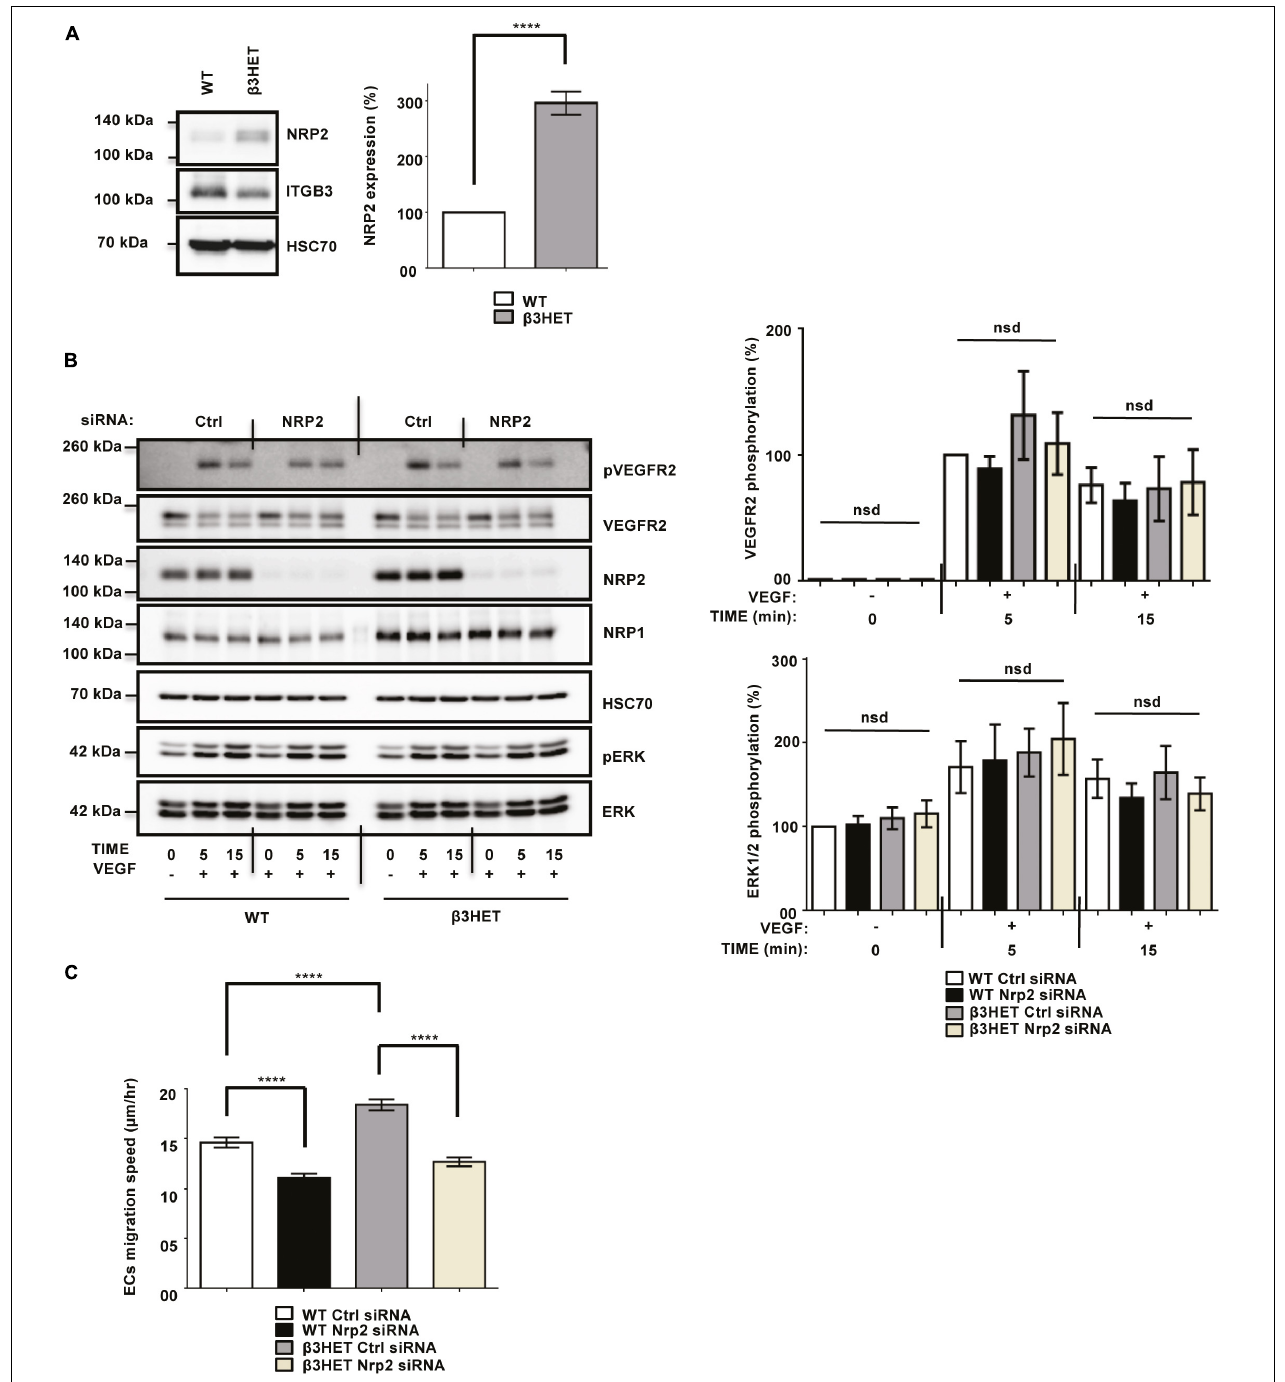
FIGURE 1 | NRP2 is not regulated by ITGB3 during VEGFR2-mediated signaling or during migration over FN. (A) : WT and β 3HET ECs were plated onto FN and incubated for 48 h at 37 ◦ C and 5% CO 2 . EC extracts were immunoblotted using antibodies to NRP2, ITGB3 and HSC70. N = 3 independent experiments, **** P < 0.0001. (B,C) : siRNA-transfected ECs were plated onto FN and incubated for 48 h at 37 ◦ C and 5% CO 2 . ECs were subsequently starved in serum-free media and stimulated with VEGF (30 ng/ml) for the indicated timepoints. EC extracts were immunoblotted using antibodies to phospho-VEGFR2, VEGFR2, NRP2, NRP1, HSC70, phospho-ERK and ERK. N = 6 independent experiments, P > 0.05 (nsd). Left panel shows representative Western blot images, right panel shows densitometric analysis of band intensities normalized against HSC70 and obtained using ImageJ TM . Asterisks indicate statistical significance, nsd indicates no significant difference from unpaired two-tailed t -tests. (C) : siRNA-transfected ECs were seeded onto FN and incubated for 3 h at 37 ◦ C and 5% CO 2 . Fixed images were taken every 10 min for 15 h at 37 ◦ C and 5% CO 2 using an inverted Zeiss Axiovert microscope with one-phase contrast. Random migration speed was quantified using the ImageJ TM plugin mTrackJ in µ m/hour. N = 4 independent experiments, n ≥ 30 ECs per experimental condition, **** P < 0.0001.